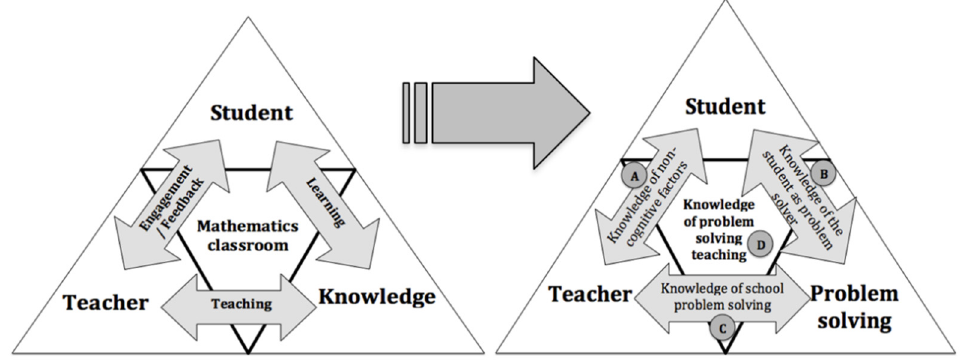
Figure 1. Pedagogical triangle and pedagogical PS knowledge triangle.